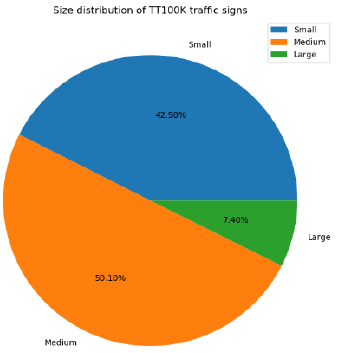
Figure 5. Size distribution of TT100K traffic signs.